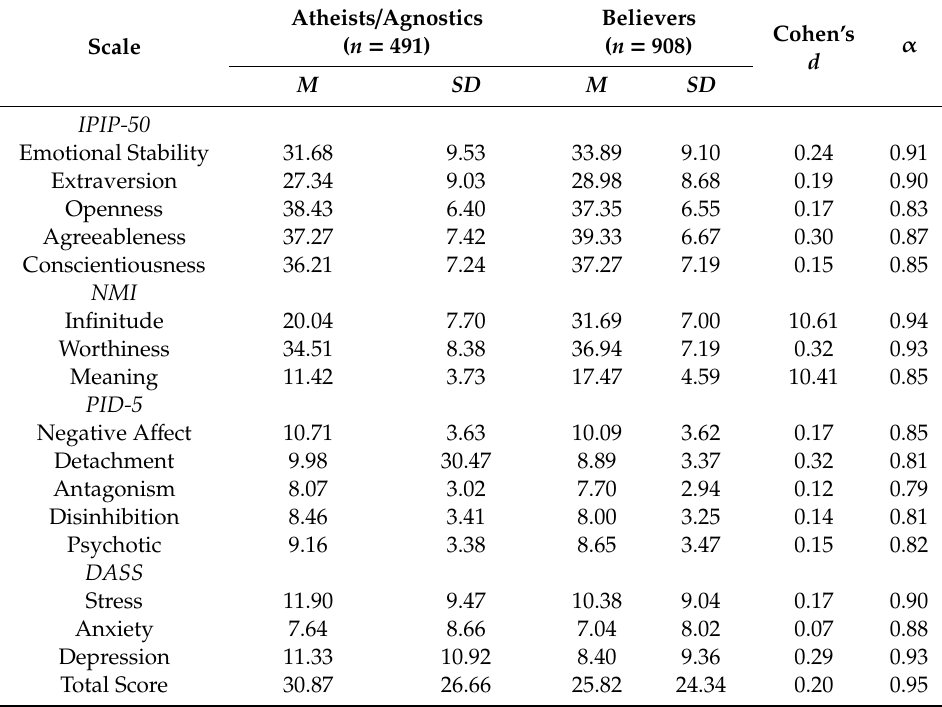
Table 1. Descriptive Statistics by Faith Orientation and Overall Alpha Reliabilities for Study Variables. Atheists / Agnostics ( n = Scale